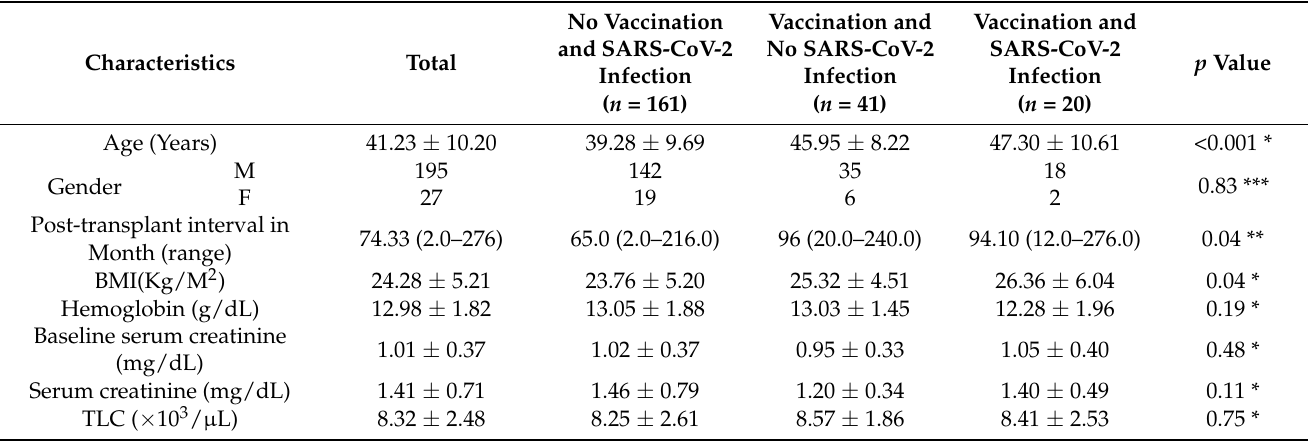
Table 1. Demographic and clinical characteristics of